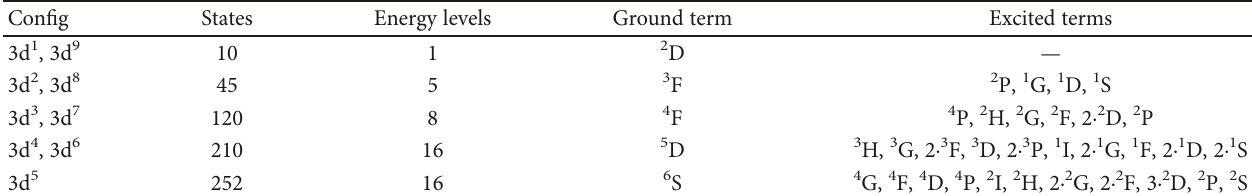
Table 1: Russell-Saunders term symbols for the 3d N free ion con fi gurations giving the number of states, the corresponding number of energy levels, and the terms for the given con fi guration. Note that d N gives the same terms as d 10 − N . A more detailed list can be found in Core Level Spectroscopy of Solids [13] (p.